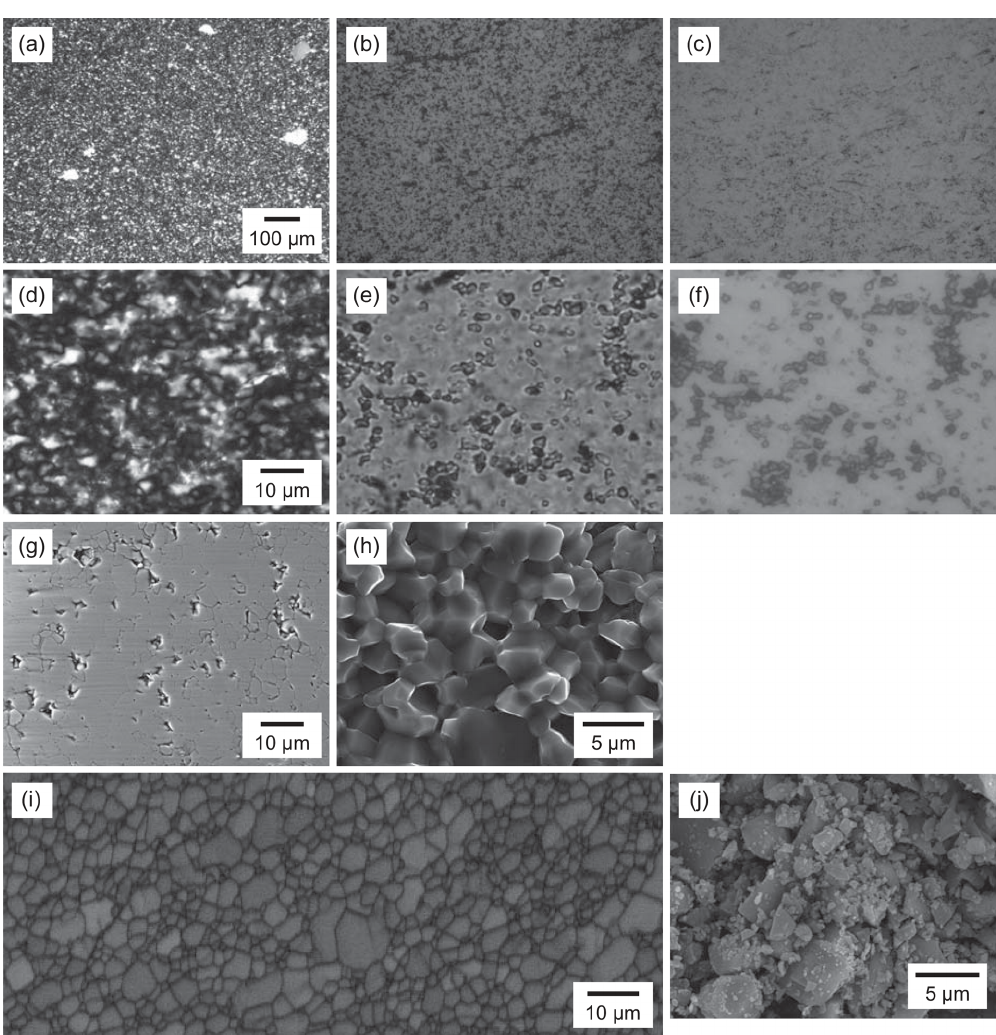
Figure 1. Textures of two different starting samples of quartz. ( a – i ) Novaculite. ( j ) Quartz powder (MIN-U-SIL 5). ( a – c ) Light photomicro- graphs and ( d – f ) enlarged images; ( a, d ) in cross-polarized light, ( b, e ) in plane-polarized light; ( c, f ) in reflected light. ( g ) SEM image of a polished surface. ( h ) SEM image of a broken surface. ( i ) EBSD band contrast image. ( j ) SEM image of the